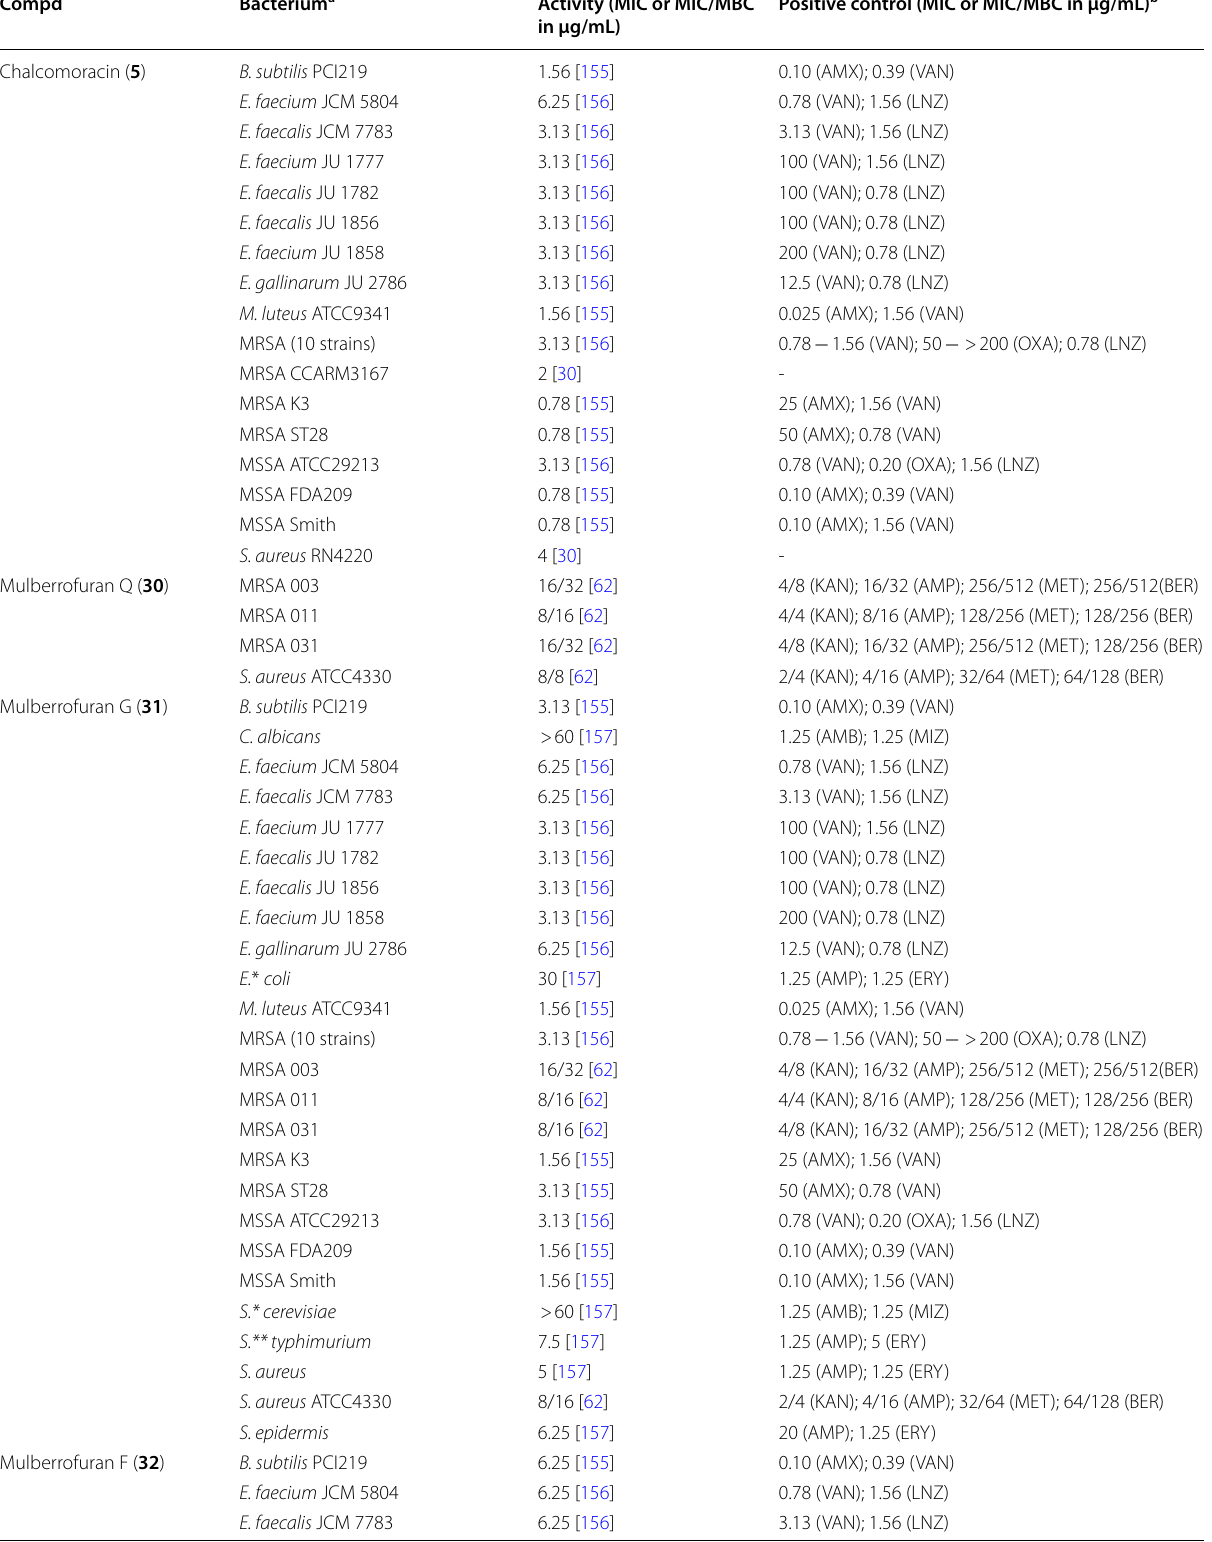
Positive control (MIC or MIC/MBC in μg/mL) b in μg/mL)